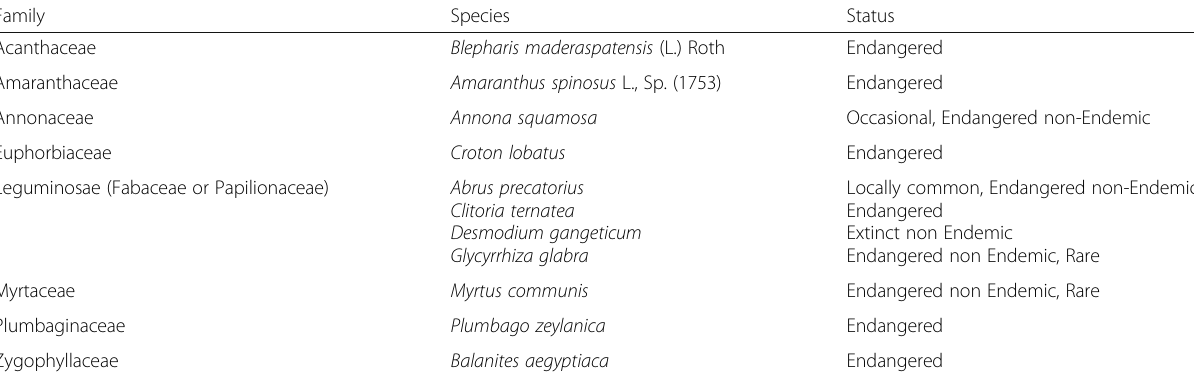
Table 1 Status of Saudi Arabian plants used for treatment of scorpion stings